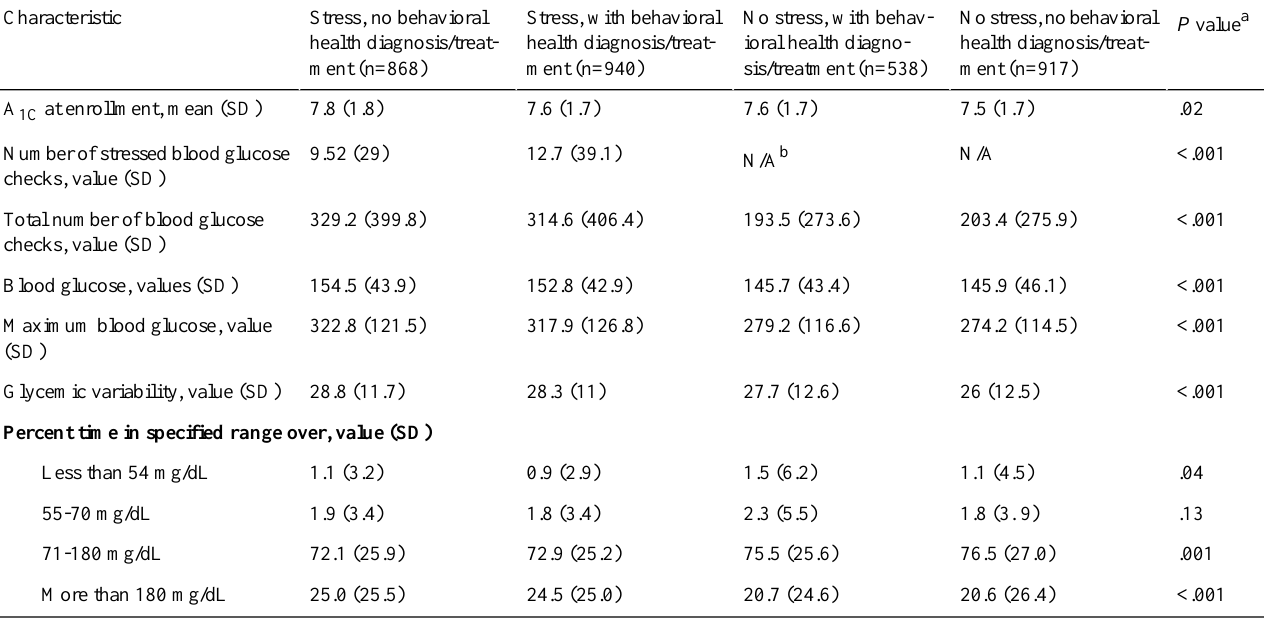
a Analysis of variance was used for between group comparisons. b N/A: not